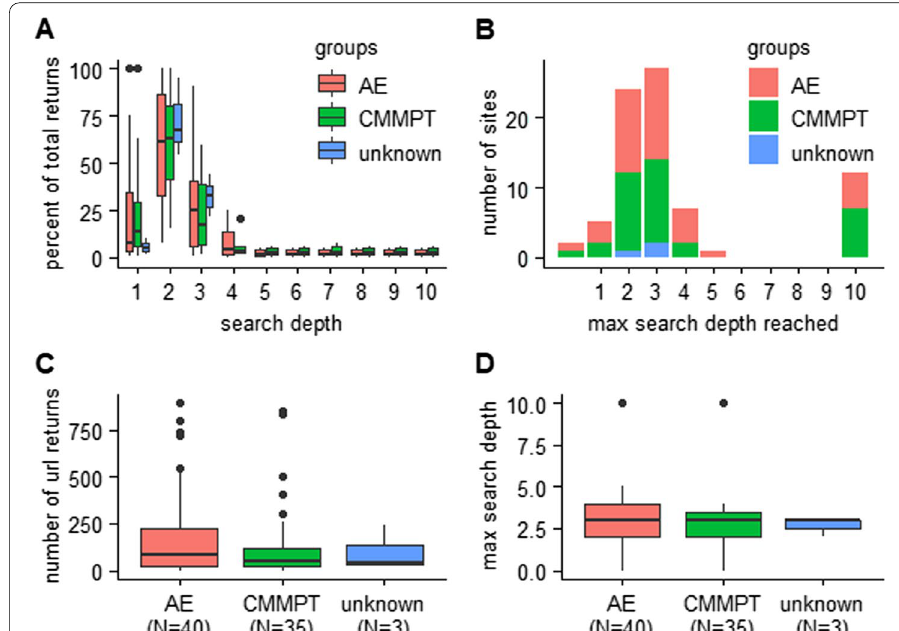
Fig. 4 Boxplots for groups AE (advocacy and education focus), CMMPT (conservation, management, monitoring, partnership, and transformation focus), and unknown focus. A The percentage of a websites’ total valid external URL that were returned at each search depth; B the number of sites that achieved their maximum depth at a given depth; C the number of valid external URL returns for each group; and D the maximum search depth that the URLs were found. Stewardship focus was not reported for three organizations, which were classified as unknown. Groups AE and CMMPT were not statistically different (Mann–Whitney U test, C p 0.375 and D 0.908). Unknowns were not statistically compared due to the small = sample. Boxplots show the data’s distribution. The thick line in the middle of the box shows the median values, with the box itself bounding 25% of the data’s distribution above and below the median (i.e., the upper and lower quartile, respectively, which together make the interquartile range). Lines extend out to show the remaining data within the largest and smallest quarters of the datasets, but do not include extreme values, or outliers (defined as larger than 1.5 times the interquartile range), which are indicated as dots. If the median of two datasets falls within each other’s interquartile range, the distributions are generally not statistically different, which is confirmed by the Man-Whitney U tests for panels C and